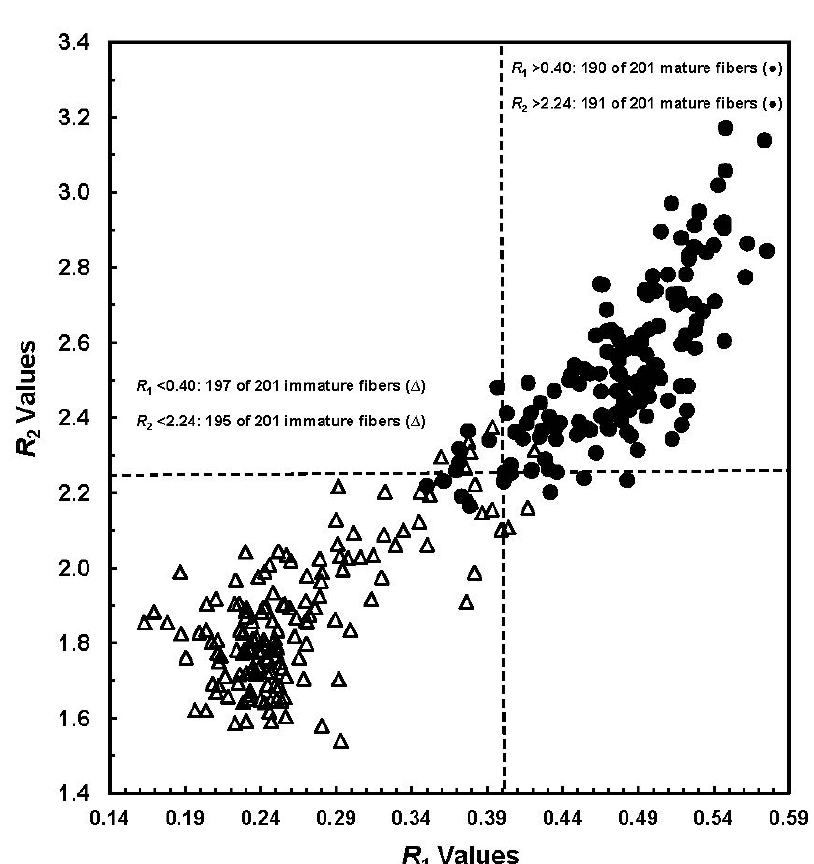
values vs. R values from a total of 402 manually selected seed cottons Figure 2. Plot of R 1 2 (Reprinted with permission from [16]. Copyright 2011